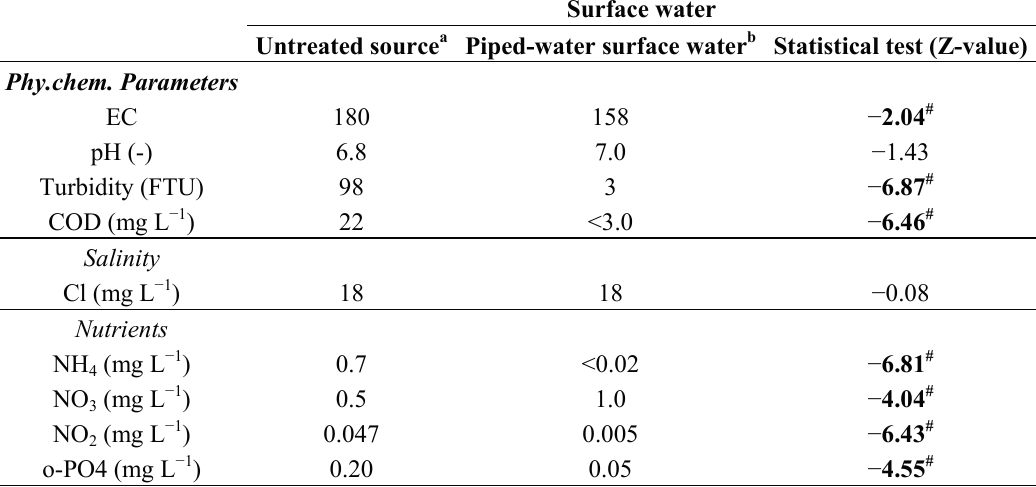
Table 2 . Median levels/concentrations of piped-water and untreated surface water in the selected study areas. Significant differences between the quality of piped-water with untreated surface water sources are visualized by calculated Z-values using the Mann-Whitney-U